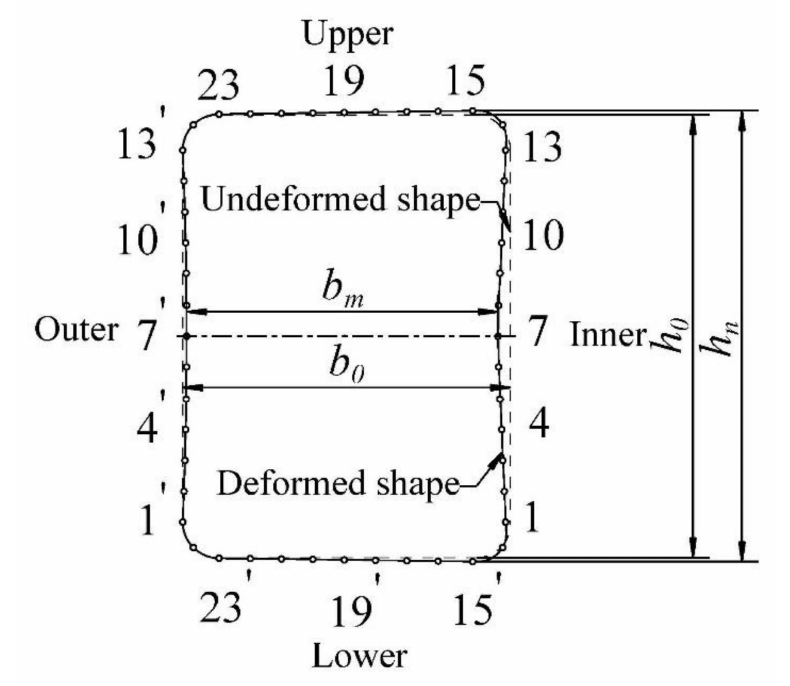
Figure 8. Geometric parameters of each measured